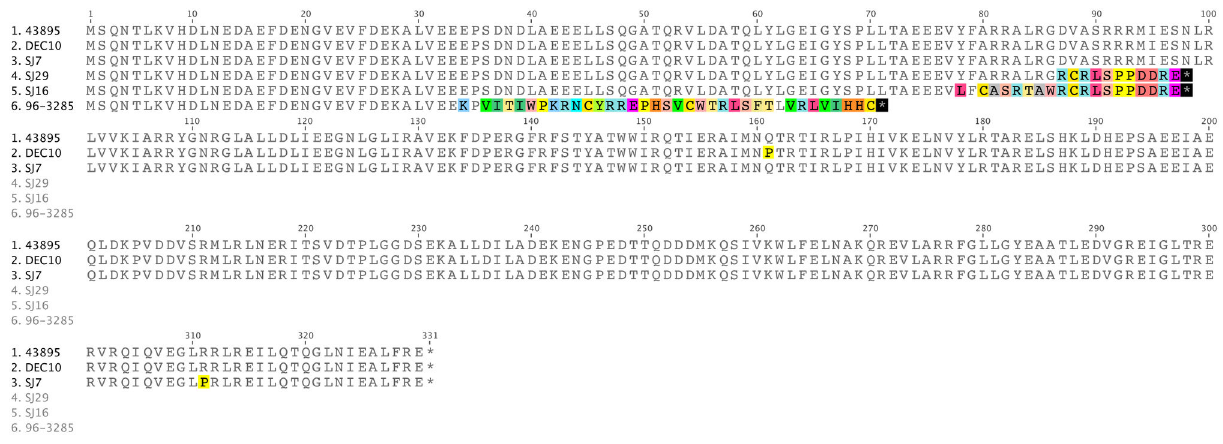
Figure 2. Protein alignment of RpoS. Mutant RpoS proteins from 5 STEC strains compared with the archetype strain ATCC 43895. Amino acids are listed by one-letter symbols.